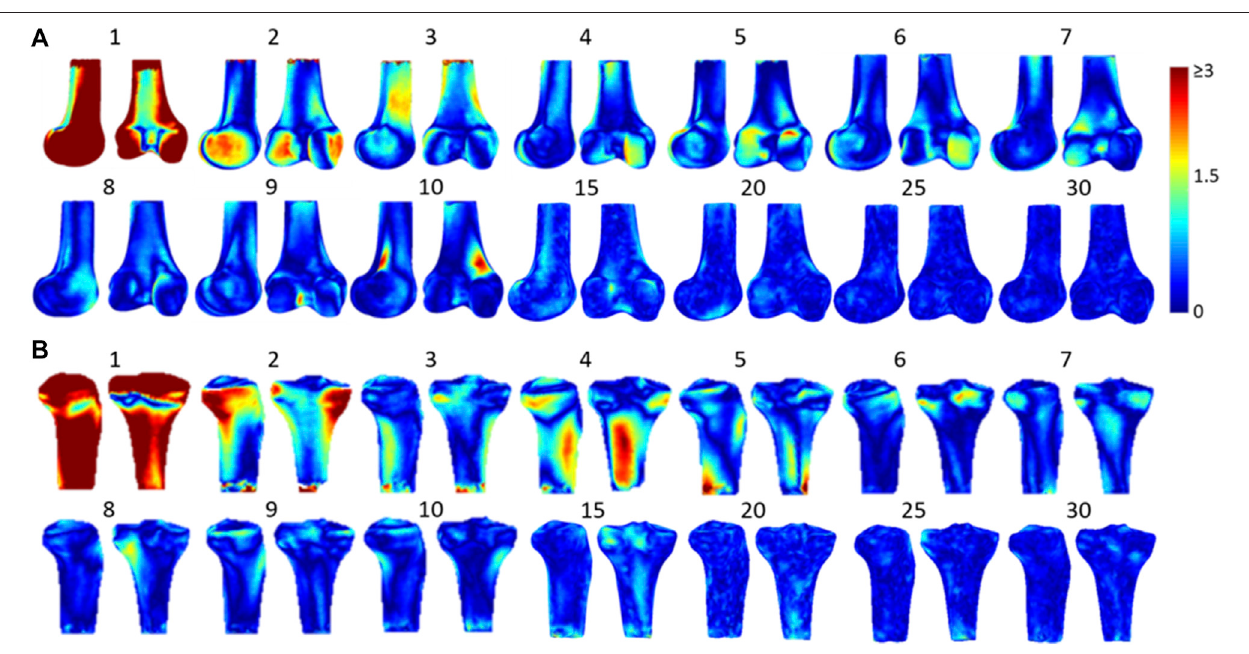
FIGURE 4 | The 3D shape variation of SSMs models of (A) the femur and (B) the tibia with colors representing the difference caused by each principal component on the reference model. The fi rst few principal components account for most of the total shape variance.